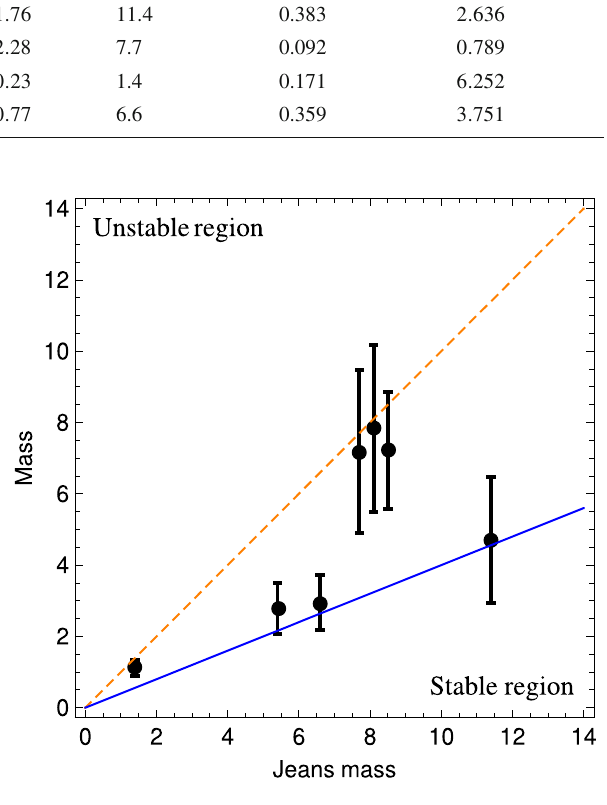
Fig. 1 Mass and Jeans mass of 7 of the Bok globules given in Table 1 whose predicted stability is contradicted by observation. The dashed line delimits between the stable region and the collapsing region for the usual Jeans criterion (in the absence of dark matter). The solid line represents the bound 2 / 5 given in Ref. [13], as a sufficient condition to account for the